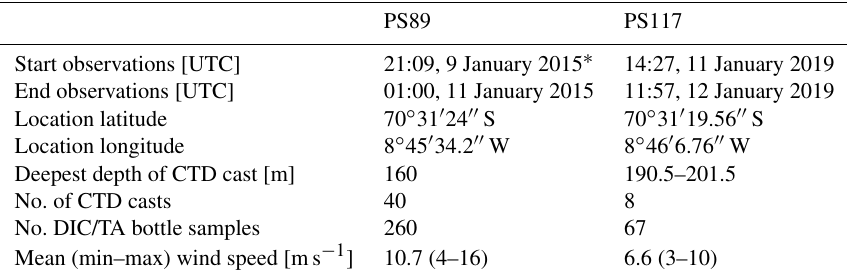
Figure 1. Map of study site. (a) Weddell Sea with bathymetry from IBSCO Version 1.0 (Arndt et al., 2013). Grey regions represent the Antarctic continent and land-fast ice, and white regions represent ice shelves. (b) Enlarged map of coastal study site along the Ekström Ice Shelf. The yellow star shows the location of the tidal measurements. See Table 1 for coordinates. Table 1. Details of the tidal observations based on repeat CTD casts and discrete seawater sampling during the two hydrographic expeditions: PS89 and PS117. For both observation periods, casts were lowered into the water during times of ebbing and rising tide. Depth of the polynya was around 165 and 200m during PS89 and PS117,